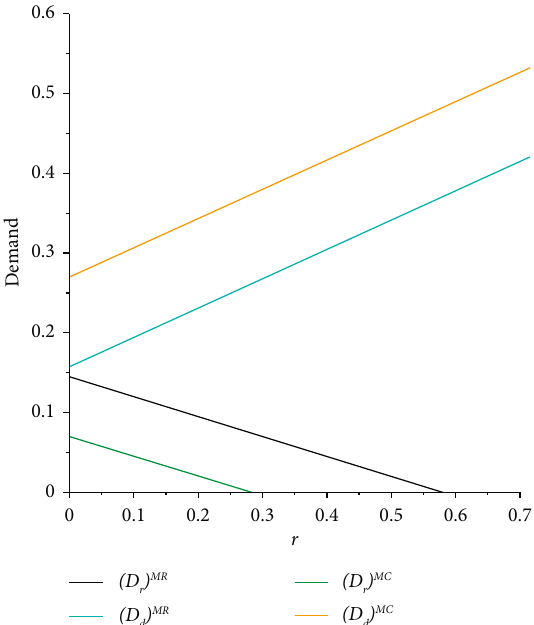
Figure 5: Effect of c i on optimal price.